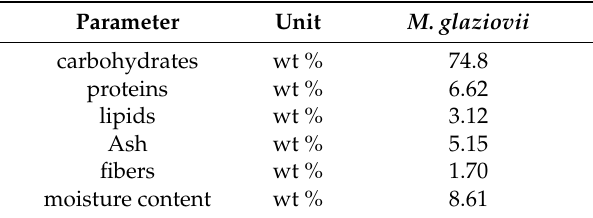
Table 3. The substrate components of M. glaziovii